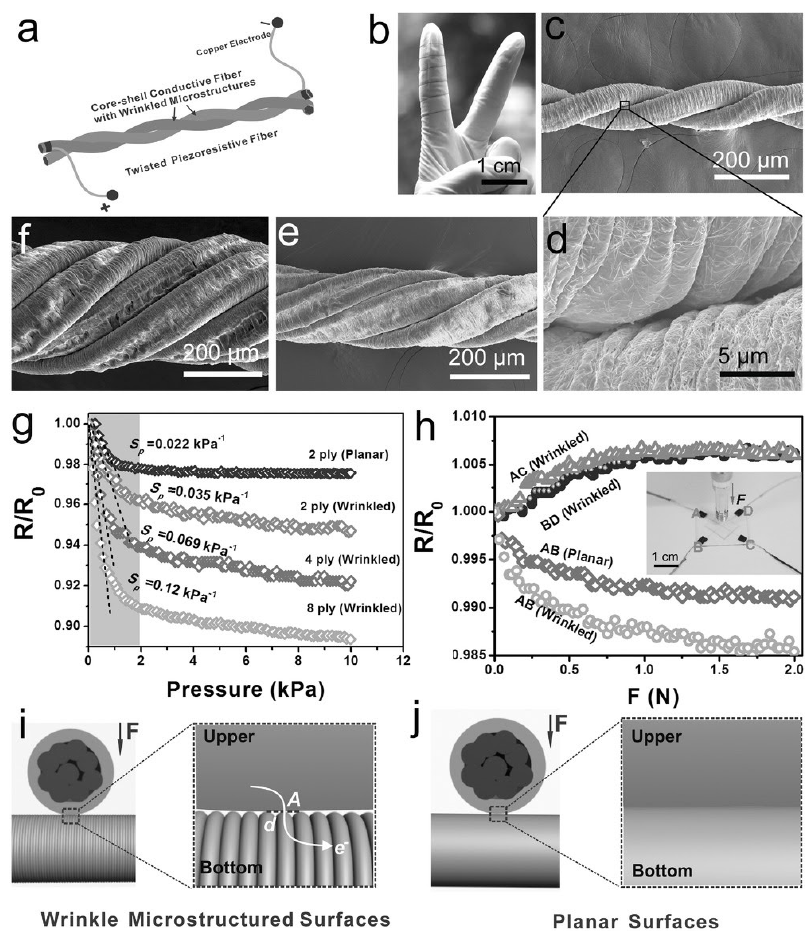
Figure 16. ( a ) AgNW coated PU twisted fiber structure; ( b ) demonstration of sensory fiber flexibility and elasticity as fiber is wrapped around finger several times; ( c ) SEM of two AgNW coated PU fiber twisted into yarn configuration with ( d ) showing the SEM of selected area of ( c ); ( e ) SEM of four AgNW coated PU fiber twisted into yarn configuration; ( f ) SEM of eight AgNW coated PU fiber twisted into yarn configuration; ( g ) strain / resistance performance of yarns that comprise di ff erent numbers of coated fibers; ( h ) mechanical testing of samples with wrinkled microstructure and non-wrinkled microstructure (planar) to investigate sensing mechanism; ( i , j ) schematic illustrations of sensing mechanisms where “A” denotes contact area and “d” indicates distance between conductive